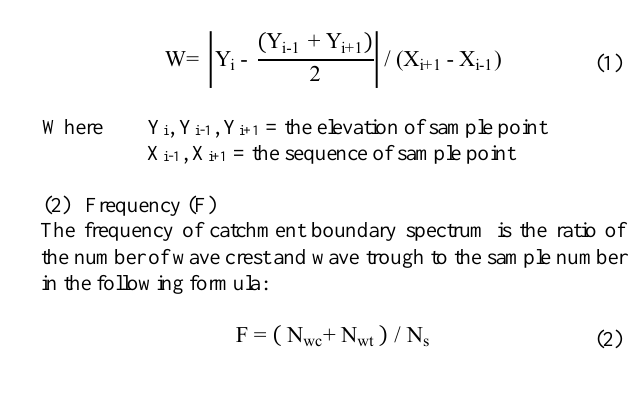
relationships and differences among the four watersheds. (1) Amplitude (W) The amplitude of catchment boundary spectrum is the difference between the elevation of the wave crest (wave trough) and the mean value of the wave trough (wave crest) on both sides of the wave crest (wave trough) in the following formula: